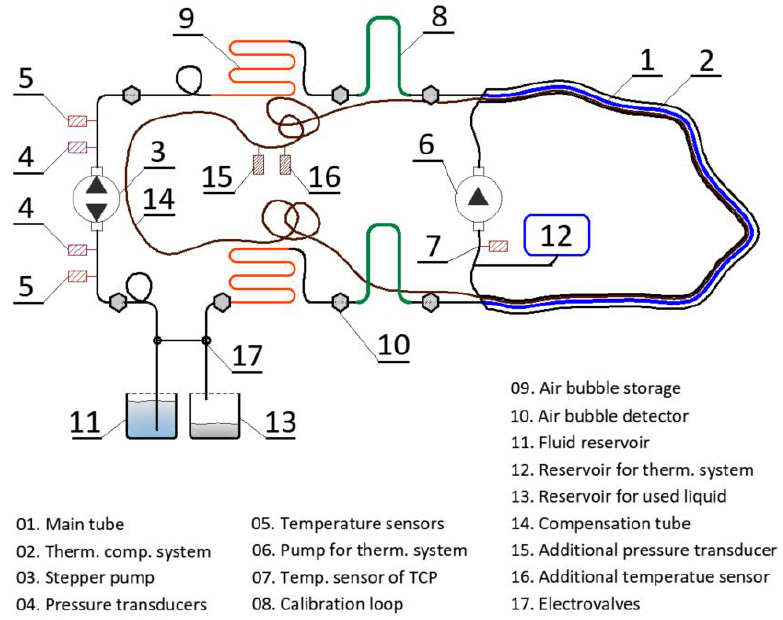
Figure 7. Scheme of hydraulic system designed for automatic operation of the new sensor.